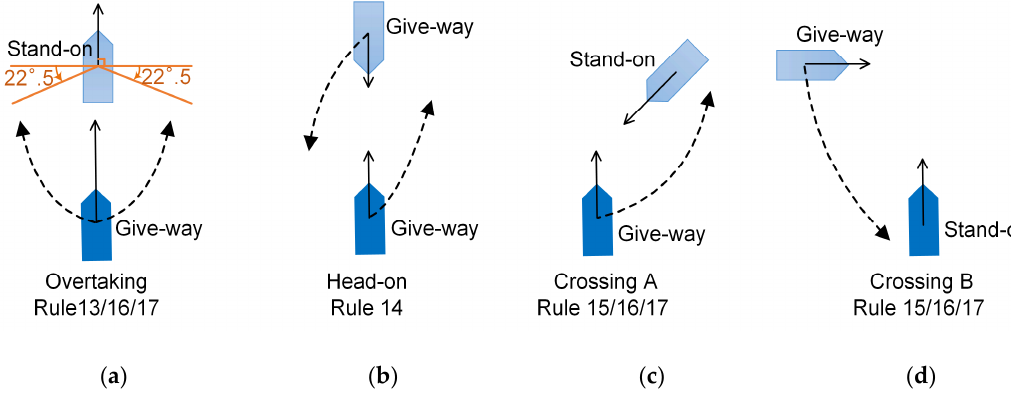
Figure 6. Typical encounters illustration: ( a ) overtaking, ( b ) Head-on, ( c ) crossing A and ( d ) crossing B and the corresponding Rules in COLREGS.